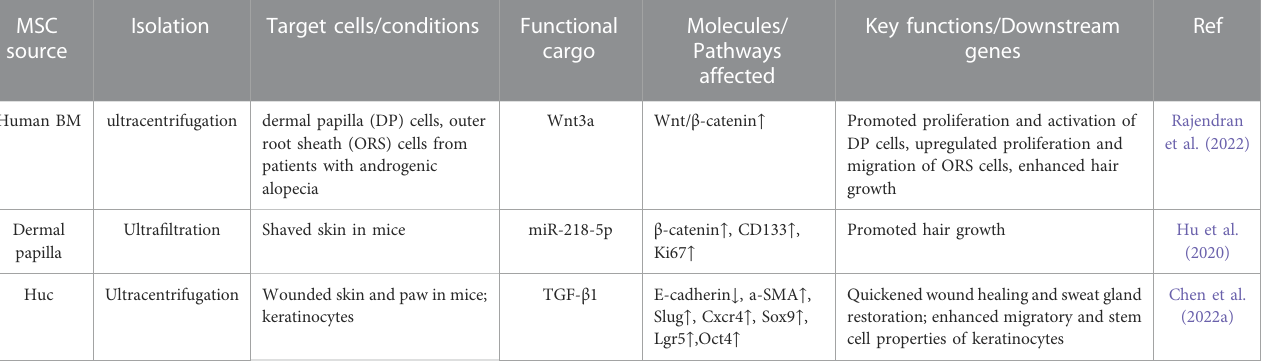
TABLE 7 MSC-sEVs enhance regeneration of skin appendages.